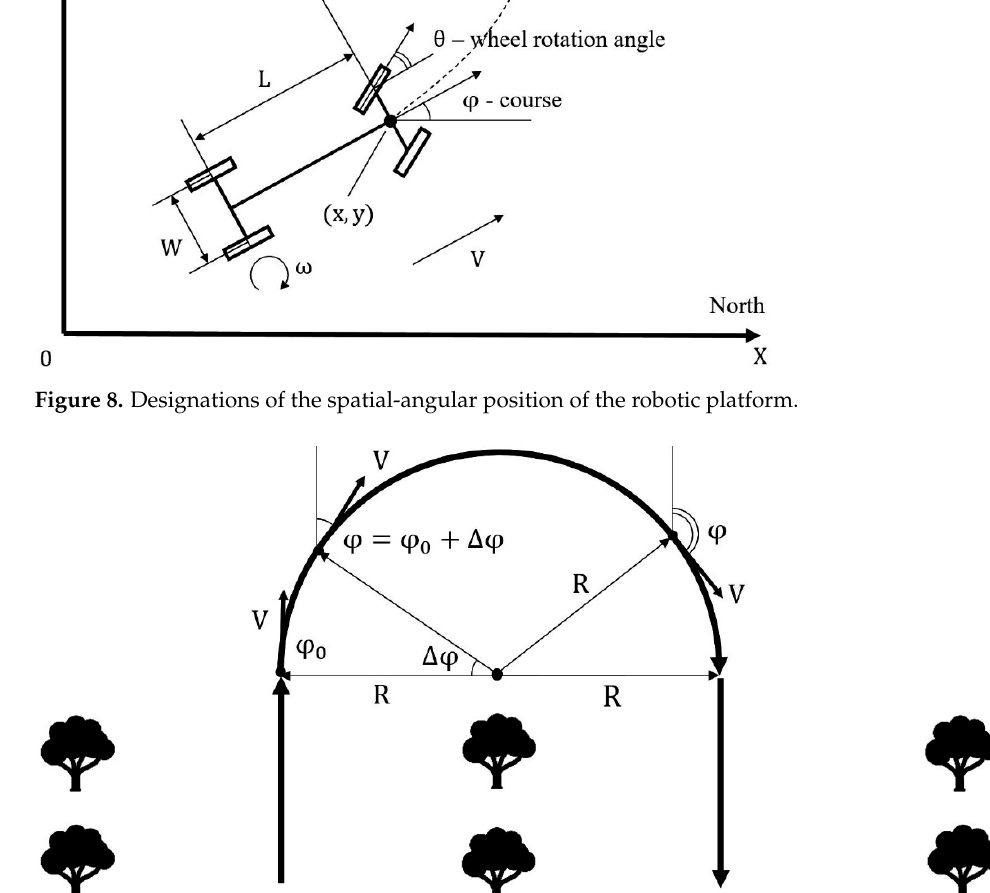
Figure 8. Designations of the spatial-angular position of the robotic platform.